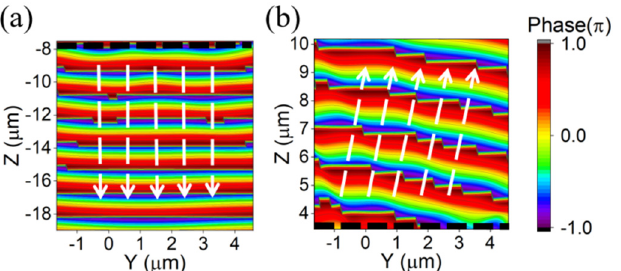
Figure 9. ( a ) Phase diagram of the Y − Z plane at the re fl ective end of the metasurface under 16° incidence of 1.55 µm x-line polarized light. The in fl uence of the isophase tilt is no longer apparent. ( b ) Phase diagram of the metasurface’s transmissive end Y − Z plane under a 16° incidence of 1.55 µm x-line polarized light.